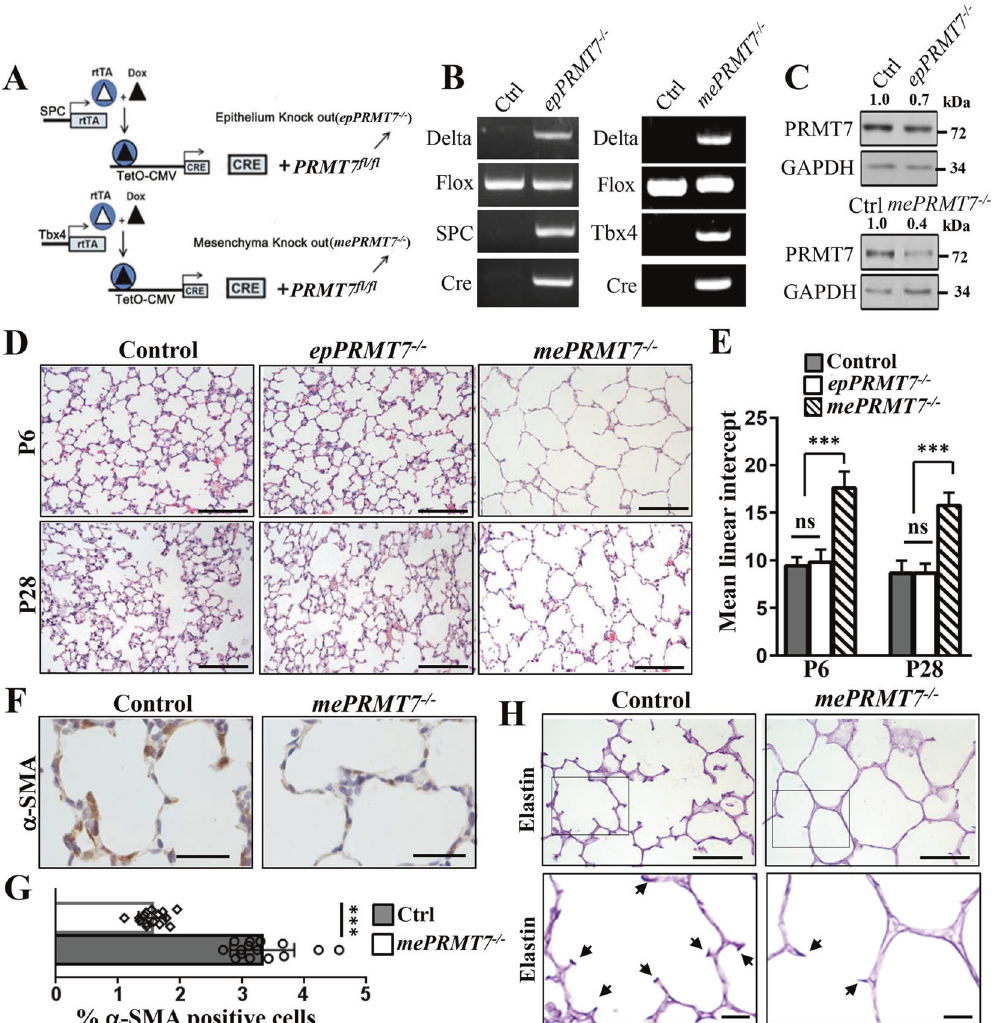
Fig. 7 Conditional knockout of PRMT7 in lung mesenchyme recapture the global PRMT7 -knockout phenotypes. A Schematic of the speci fi cally knockout strategy used to delete the PRMT7 gene in lung mesenchyme or epithelium lineages. In triple-transgenic mice ( epPRMT7 − / − or mePRMT7 − / − ), rtTA is expressed in epithelium or mesenchyme under the control of SPC or Tbx4 promoter, respectively. In the presence of doxycycline (Dox), rtTA binds to the tetO-CMV promoter to activate Cre-recombinase expression, resulted in recombination and deletion of PRMT7 gene in PRMT7 fl / fl mice. B PCR genotyping of the offspring from epithelium PRMT7 -knockout ( epPRMT7 − / − ) and mesenchyme PRMT7 -knockout ( mePRMT7 − / − ). C Western blotting showing downregulated PRMT7 expression levels in epPRMT7 − / − and mePRMT7 − / − lung tissues. The relative PRMT7 expression level was listed above. GAPDH was served as a loading control. D Representative H&E staining images from epPRMT7 − / − and mePRMT7 − / − lung tissues at P6 and P28. Scale bars: 100 μ m. E Quantitated bar graphs of the mean linear intercept. The mean free distance in airspaces was signi fi cantly larger in mePRMT7 − / − lungs at P6 and P28, but no difference between control and epPRMT7 − / − mice. Data were shown as mean ± SD. n = 8 mice per genotype. ns not signi fi cant, *** P < 0.001 (one-way ANOVA with Tukey ’ s test). F Representative staining images showing decreased α -SMA expression in lung tissues of mePRMT7 − / − at P6. Scale bars: 50 μ m. G the quanti fi cation result of α -SMA positive cells as shown in ( F ). The α -SMA + cells located in alveolar regions were quanti fi ed. Data were presented as mean ± SD. n = 15 fi elds from six mice per genotype. *** P < 0.001 (Student ’ s t -test). H Representative elastin staining images from lung tissue of control and mePRMT7 − / − mice. Scale bars: 50 μ m. The boxed area was magni fi ed below. Arrows indicate a positive elastin